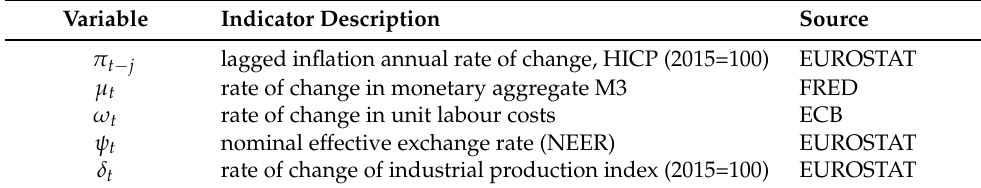
Table 1. Indicator description and the source of exogenous variables (inputs).